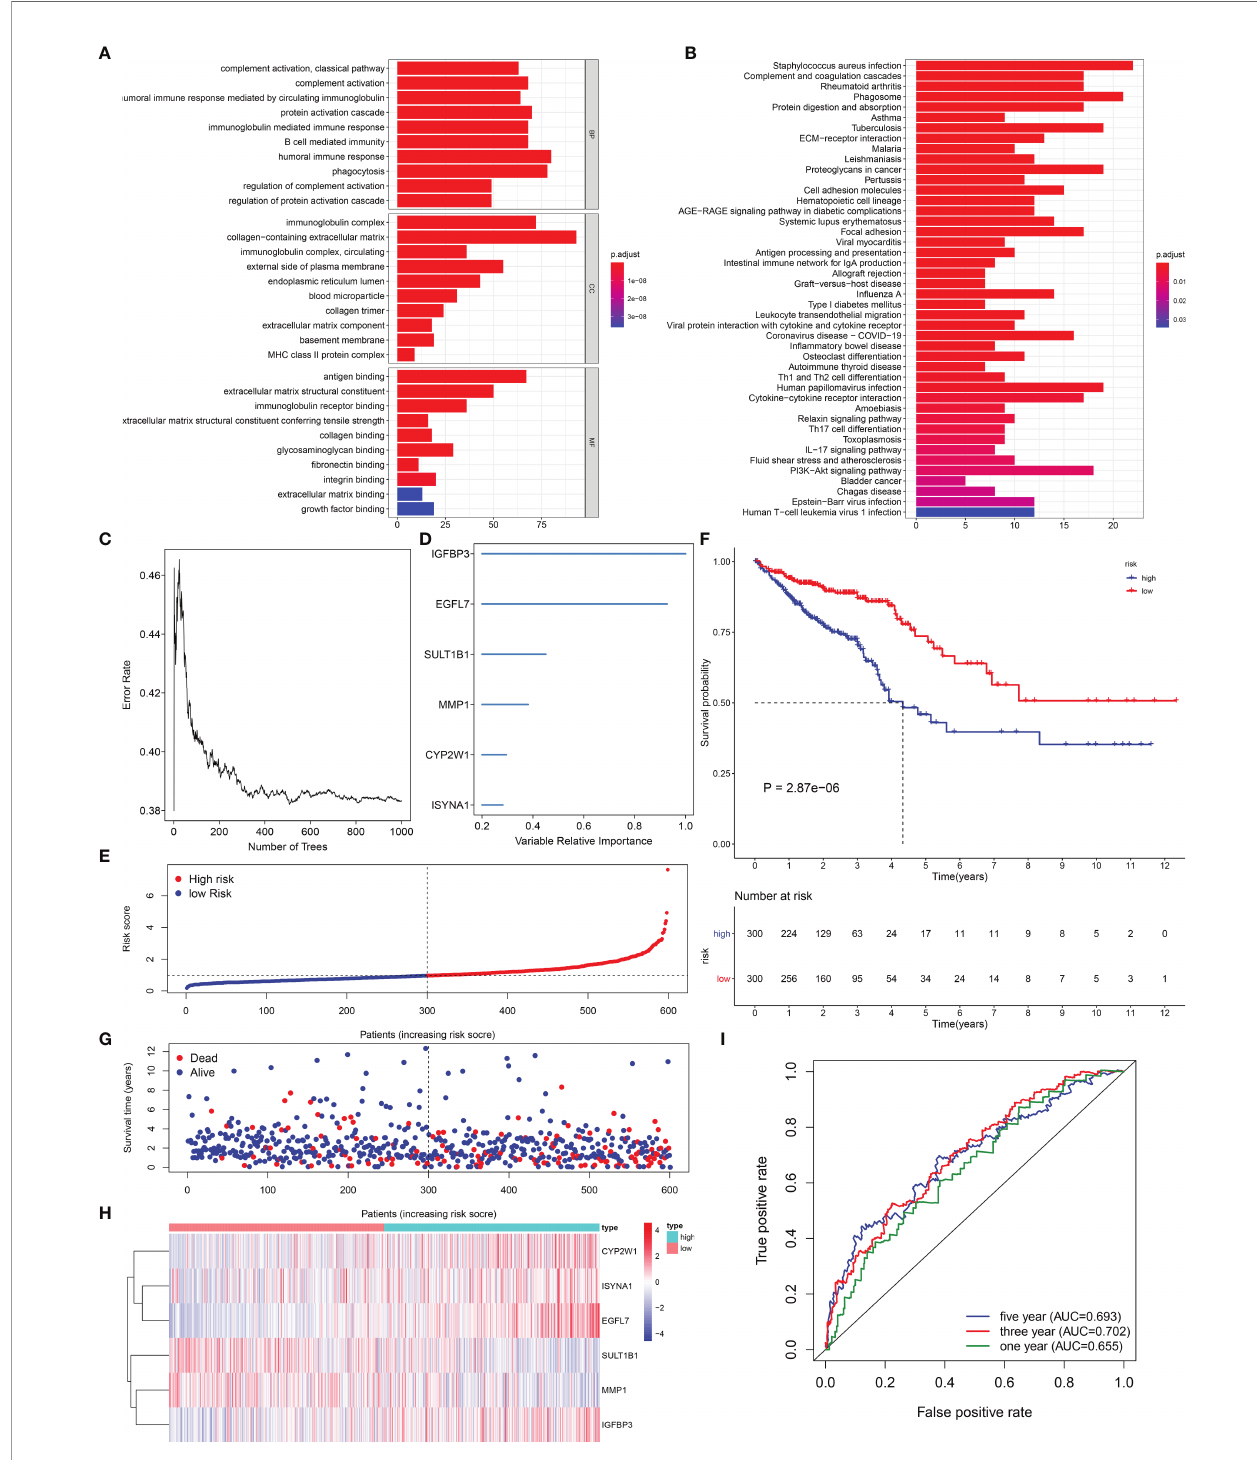
FIGURE 6 | Exploitation of an EVA1B-derived genomic model for CRC prognosis. (A, B) GO and KEGG enrichment analyses of EVA1B-derived genes. (C) Random survival forest analysis for calculating the relative importance of EVA1B-derived genes. (D) Determination of characteristic EVA1B-derived genes with relative importance >0.28. (E) Distribution of high- and low-risk CRC subpopulations with the mean value (vertical dashed line) of EVA1B-derived risk score. (F) Kaplan – Meier curves of OS for high and low CRC subpopulations. (G) Distribution of survival status in two CRC subpopulations. (H) Heatmap for the expression of IGFBP3, EGFL7, SULT1B1, MMP1, CYP2W1, as well as ISYNA1 in two CRC subpopulations. (I) ROC curves at 1-, 3-, and 5-year OS outcomes in accordance with EVA1B- derived risk